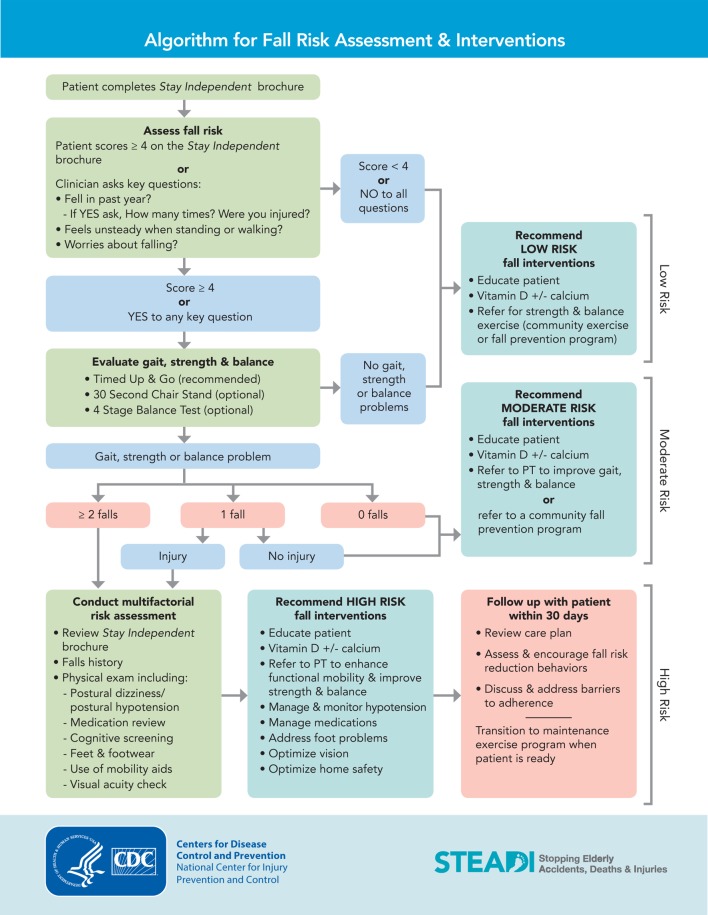
STEADI algorithm for fall risk assessment and intervention. Available from: https://www.cdc.gov/steadi/pdf/algorithm_2015-04-a.pdf.